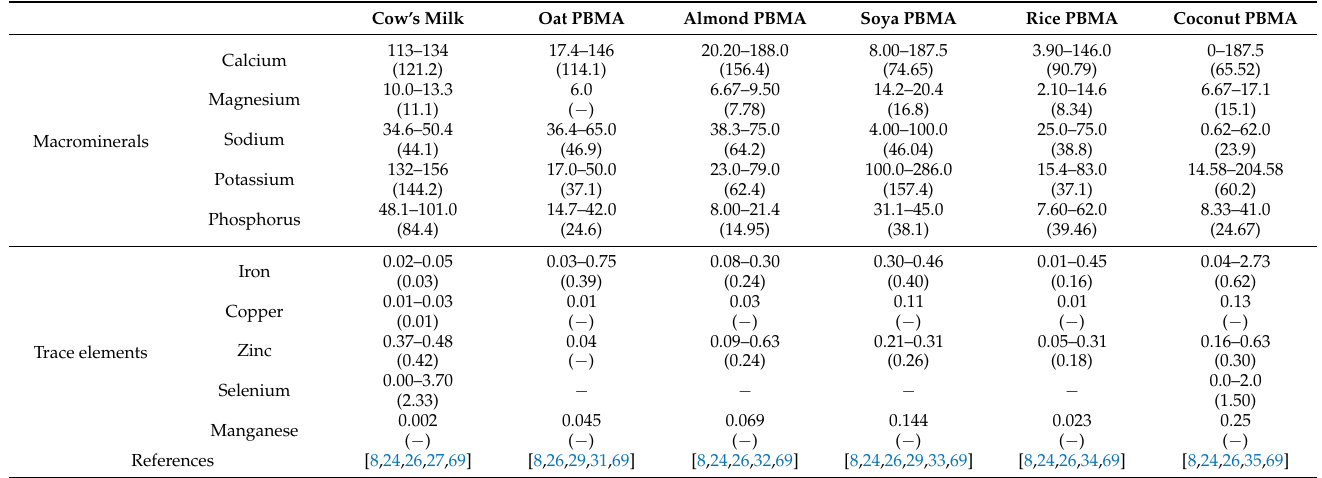
Table 5. Mineral composition (macrominerals and trace elements expressed as mg/100 mL) of cow’s milk and some (oat, almond, soya, rice, and coconut) plant-based milk alternatives (PBMA). The data are presented as the range and the average in